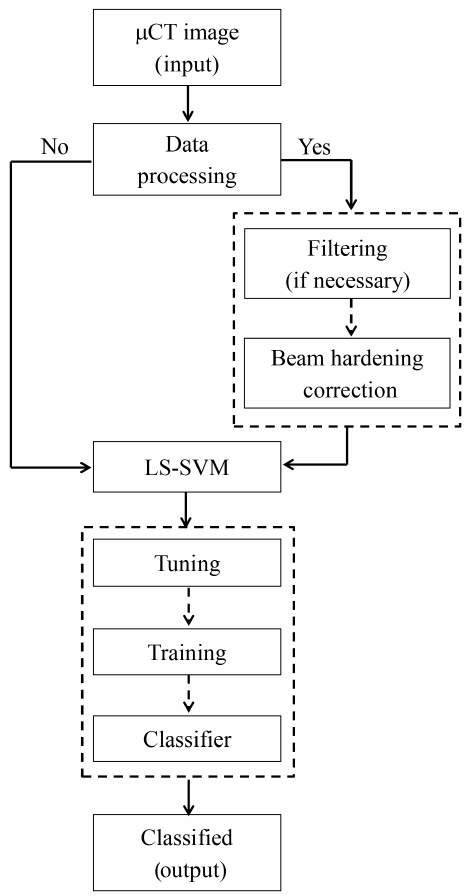
Figure 2. Workflow chart of our proposed µ XCT image post- processing method that combines BH correction with an LS-SVM segmentation